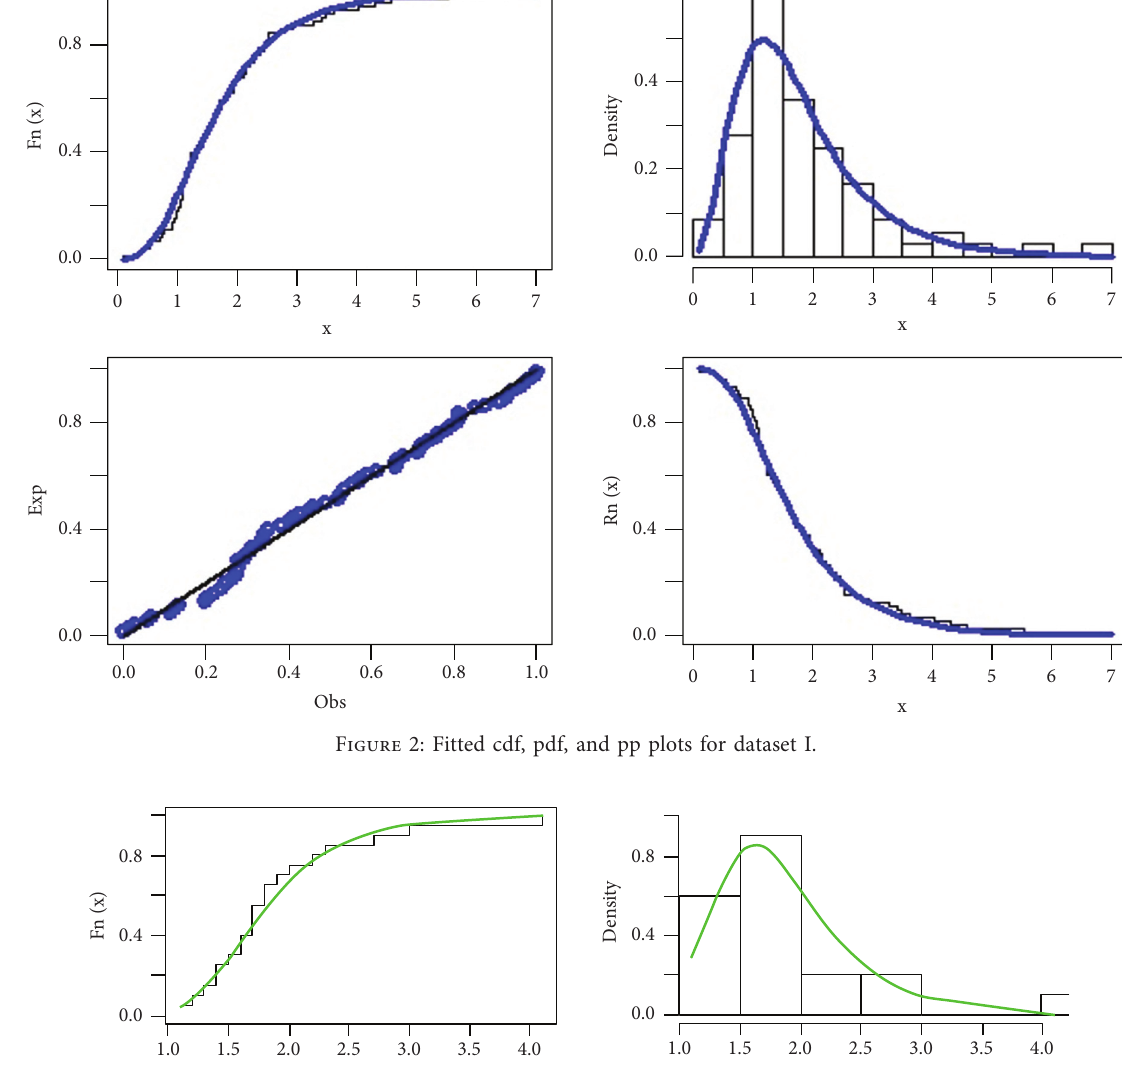
Figure 2: Fitted cdf, pdf, and pp plots for dataset I.